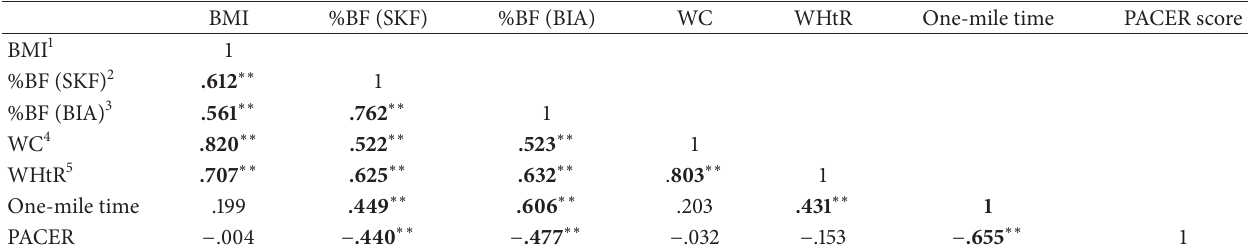
Table 5: Correlation matrix showing anthropometric measures and cardiorespiratory fitness scores for boys. BMI %BF